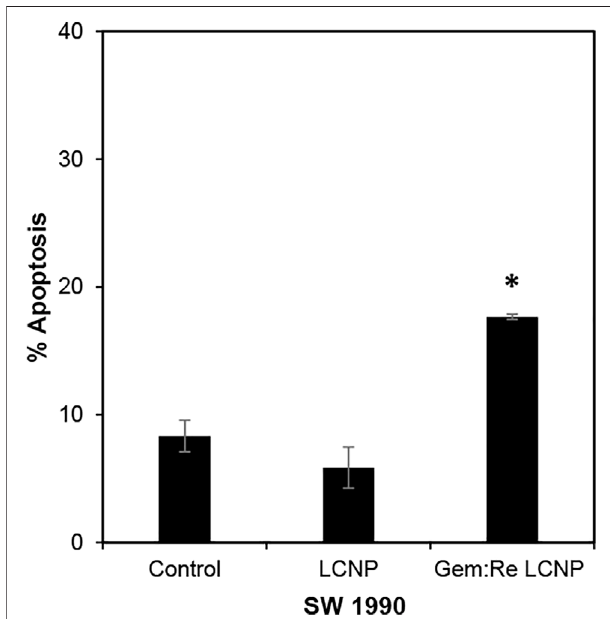
FIGURE 9 | Percentage of cells undergoing apoptosis was determined usingannexinV/7-AAD fl owcytometricanalysisofSW1990pancreaticcancer cells treated with IC 50 values of Gem:Re LCNPs (1:1) and blank LCNPs for 48 h. Bars indicate the mean ± standard deviation of three independent experiments. Asterisks (*) represent statistical signi fi cance in comparison with control cells and cells treated with blank LCNPs ( p < 0.05, Student ’ s t -test).